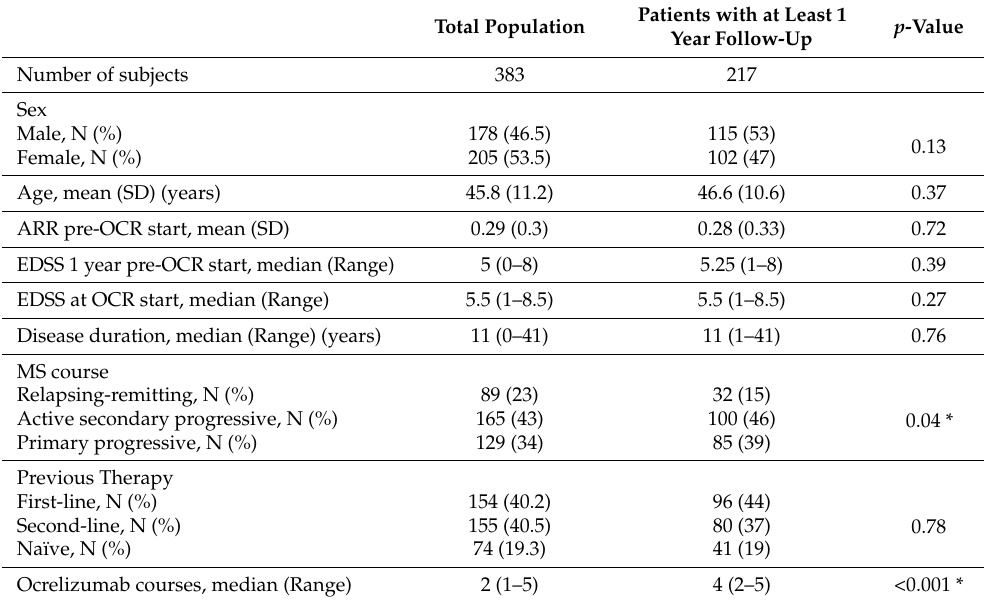
Table 1. Demographic and clinical features for the whole sample and for patients included in the effectiveness analysis.